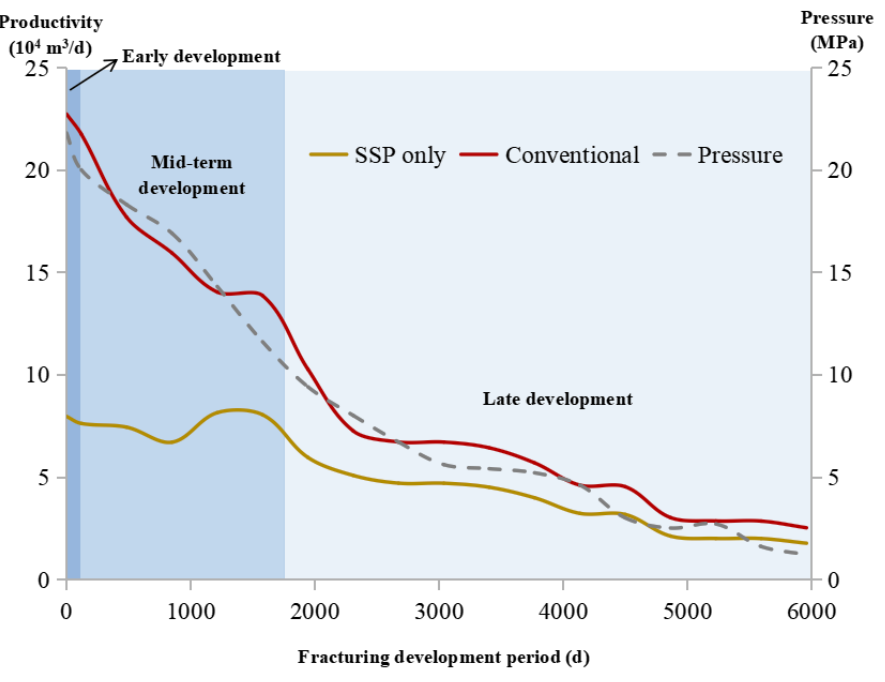
Figure 8. Influence of pollution on gas reservoir production under the condition of only solid solute pollution from fracturing water.